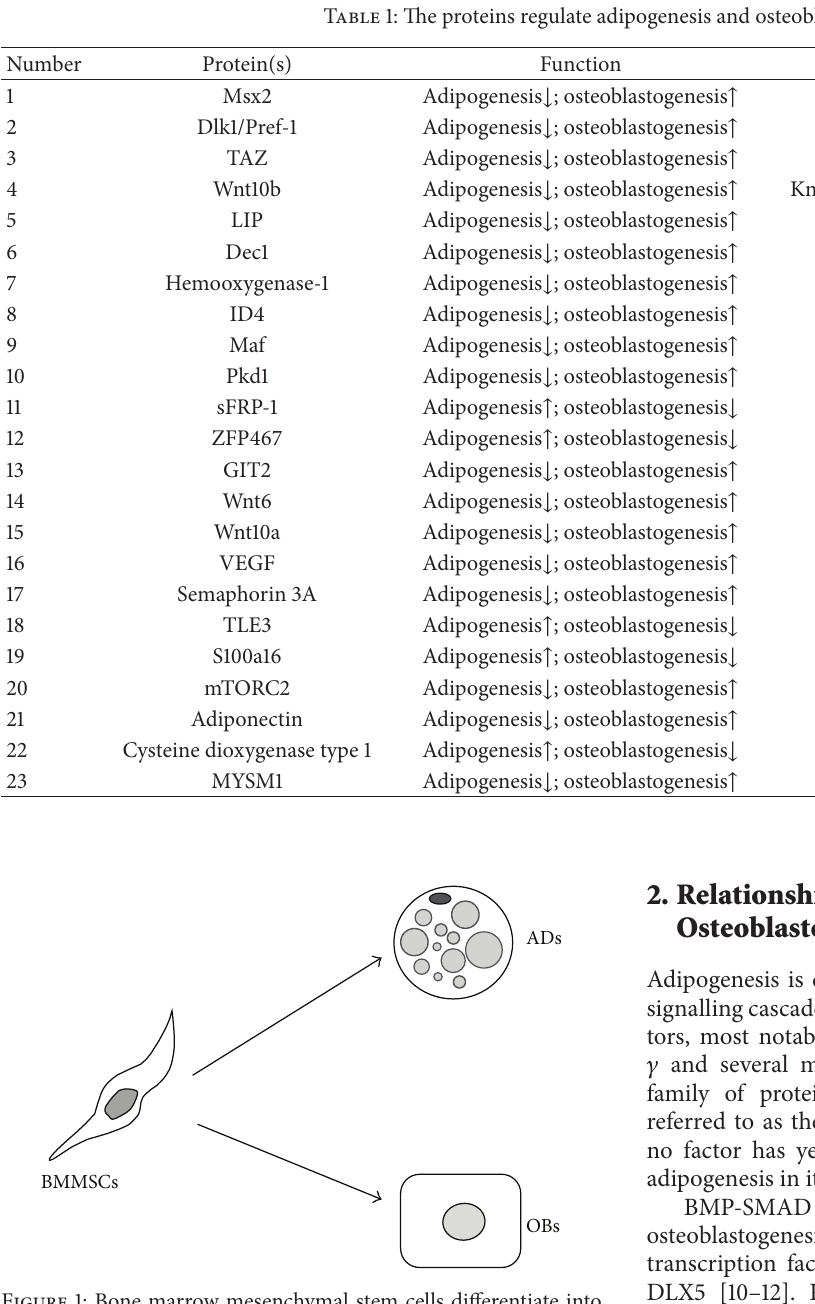
Figure 1: Bone marrow mesenchymal stem cells differentiate into both adipocytes and osteoblasts. Osteoblast and marrow adipocytes are derived from common progenitors, the bone marrow mesenchy- mal stem cells. BMMSCs: bone marrow mesenchymal stem cells; OBs: osteoblasts; ADs: